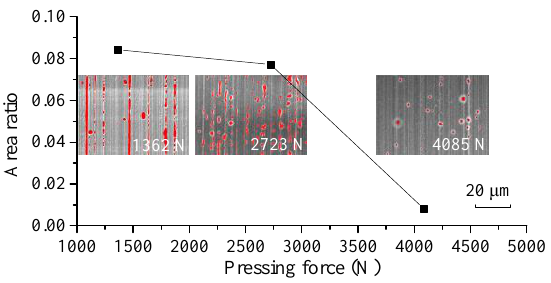
Figure 17. Area ratios of the microdimples of the formed ChG pillars under different pressing forces at 382 °C.